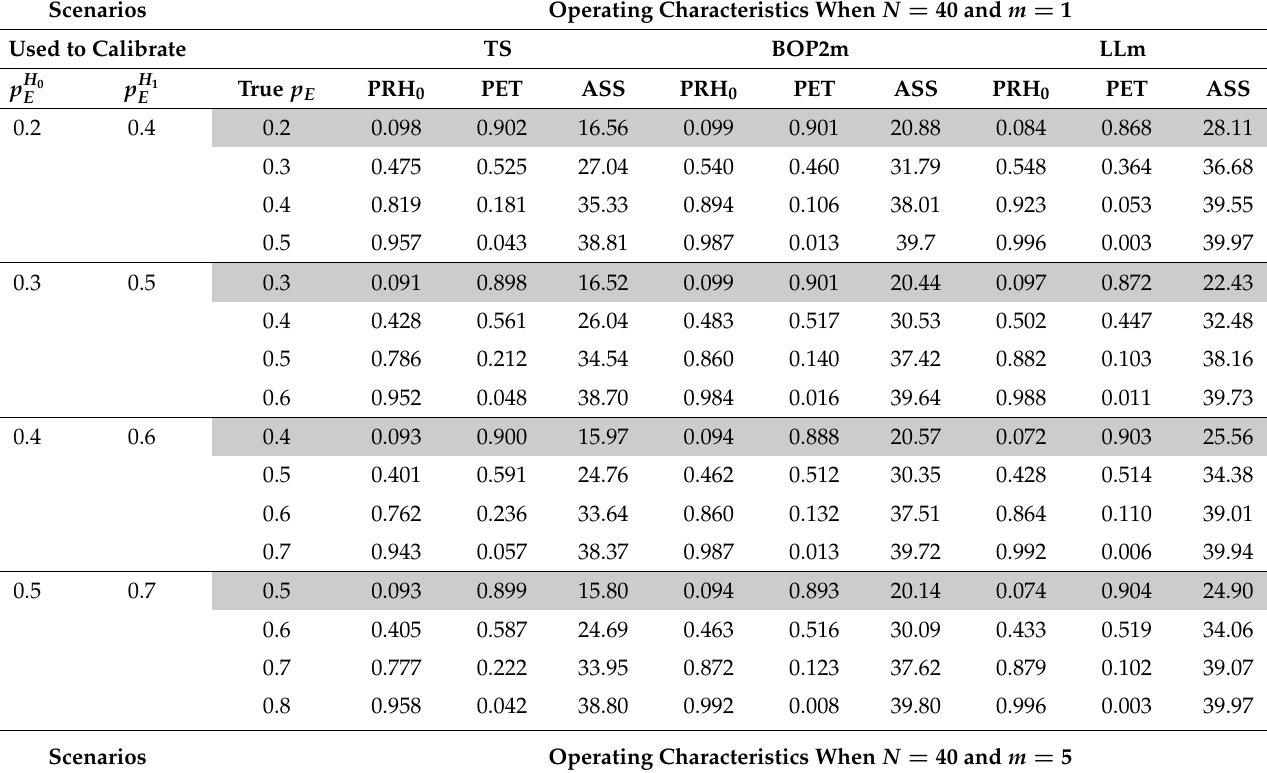
Table 4. Operating characteristics of the TS, BOP2m and LLm designs, when N min = 10, δ = 0.1, N = 40 and the type I error rate is controlled at the level 0.1. The lines in gray represent the operating characteristics under the null